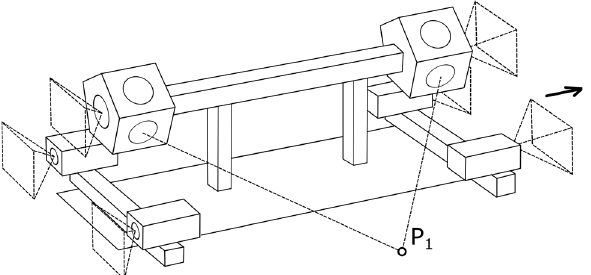
Figure 2. Novel configuration featuring several stereo camera systems for 360° RGBD mapping (patent